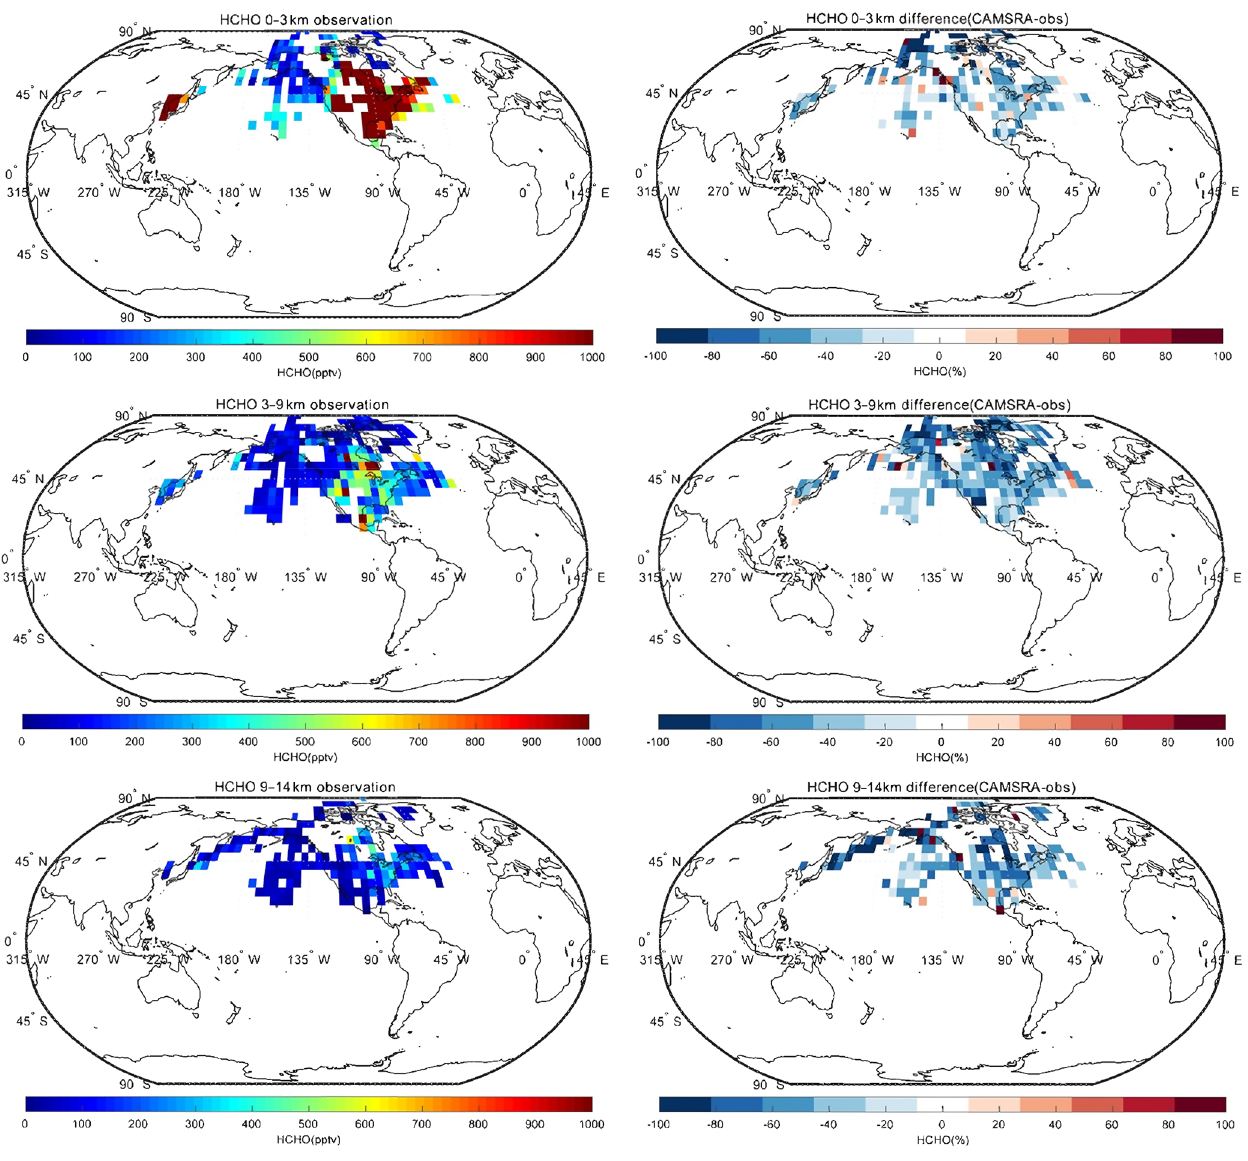
Figure A2. Same as Fig. A1, but for